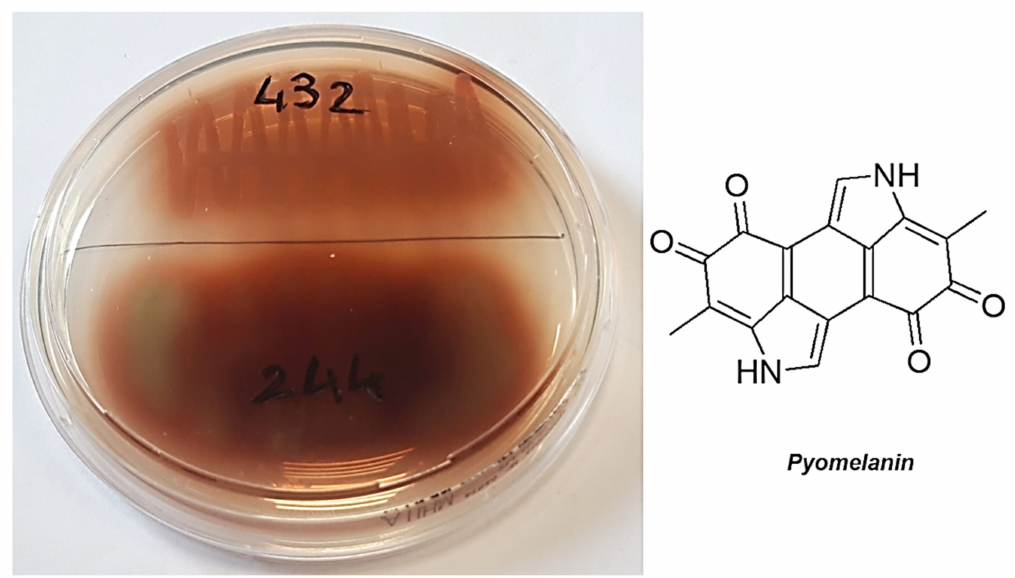
Figure 3. Colonies producing pyomelanin and its chemical